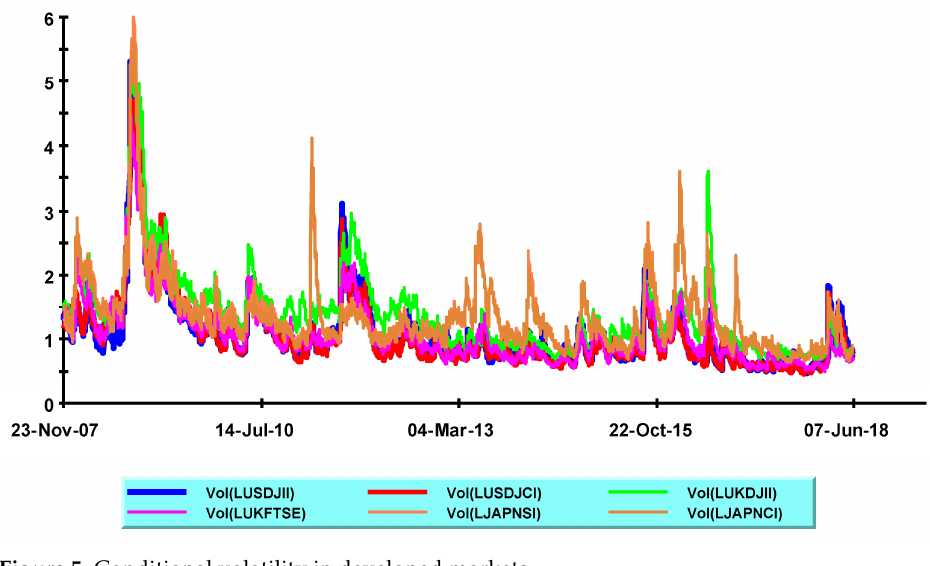
Figure 5. Conditional volatility in developed markets.